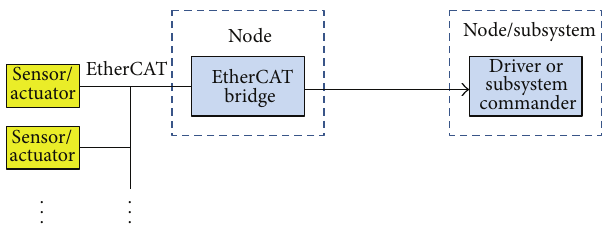
Figure 12: The next stage in the evolution to EtherCAT based sensors and actuators (Figure 3-4 in [19]).